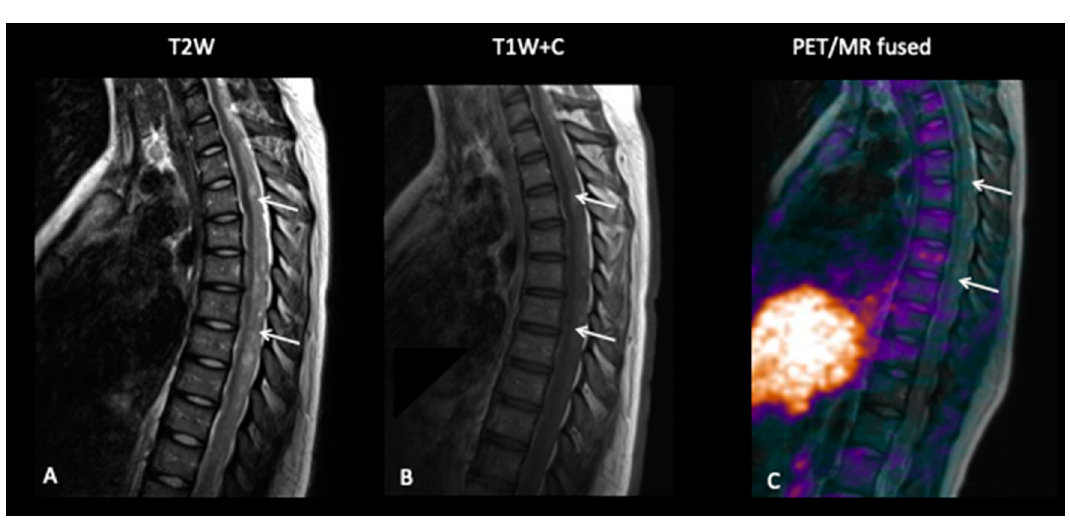
Figure 13. Spinal MRI ( A , B ) demonstrates extensive intraspinal-enhancing soft tissue in keeping with leptomeningeal metastatic disease (arrows point out the leptomeningeal disease). However, the FCho PET ( C ) did not demonstrate avidity of the leptomeningeal disease (arrows).